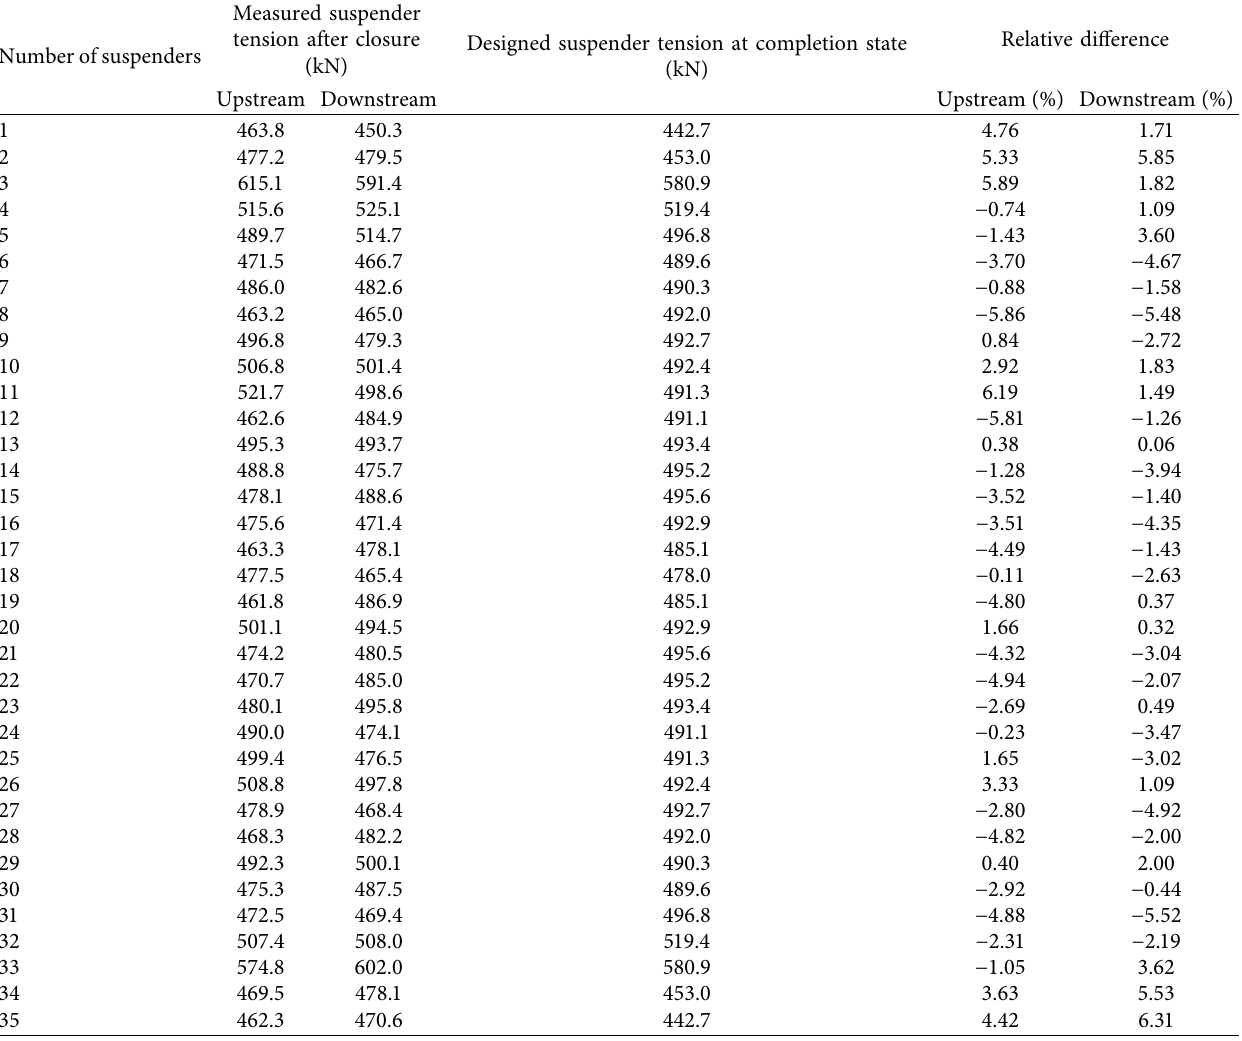
Table 4: Value comparison between measured and designed suspender tension at completion state.